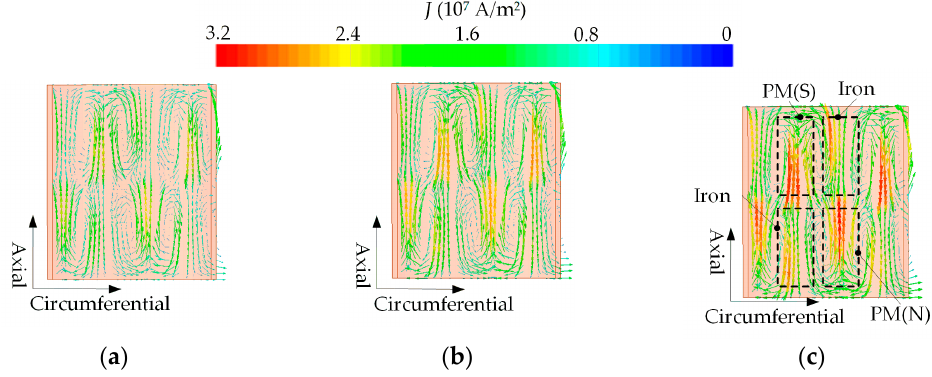
− 10 A. ( b ) I f = f = 0 A. ( c ) I f = 10